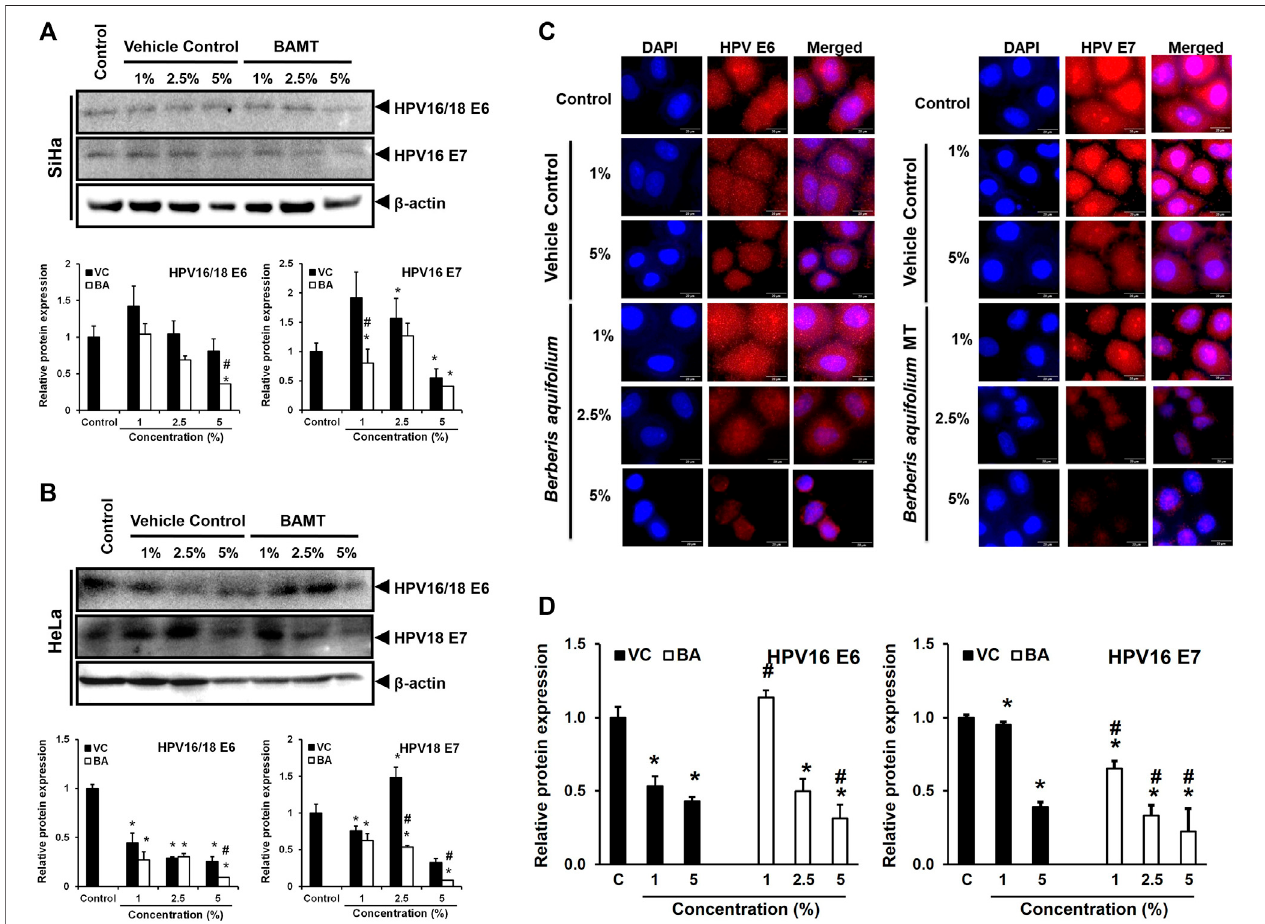
FIGURE 5 | Effect of BAMT on expression of HPV oncoproteins E6 and E7 and localization. A. and B. Lower blot (with ≤ 25 kDa proteins) of the representative experiment shown in Figure 3 . BAMT-treated SiHa (A) or HeLa cells (B) were fi rst probed for HPV E6, and then re-probed for HPV E7 (upper panels) . * β -actin of corresponding upper blot is reproduced for comparison. Graphs (Lower panels) show aggregated normalized fold change in band intensities of HPV E6 and HPV E7 obtained from densitometric analysis. Values are means ± S.D. (indicated as error bars) of the three independent measurements. C. and D. Representative fl uorescencephotomicrographsshowingdistributionofHPV16E6andE7inBAMT-treatedandcontrolSiHacellsbyimmunocytochemistry (C) .Cellswere fi xed,stained with HPV16/18 E6 and HPV16 E7 antibodies and detected with goat anti-mouse IgG-Alexa-594 (Red) and counterstained with DAPI (Blue). The expression level was measuredbyImageJandplottedasmean ± SEMoftherepresentative experimentoutofthreeindependentexperiments (D) .Valueswereobtainedbyanalyzingat least 30 cells per specimen. * p value < 0.05 vs. control. # p value < 0.05 vs. vehicle control (VC).